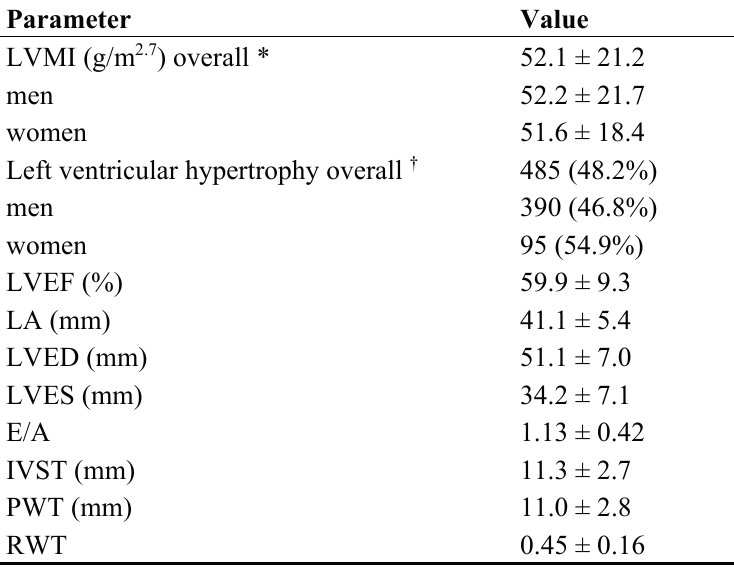
Table 2. Echocardiographic parameters of study cohort ( N =